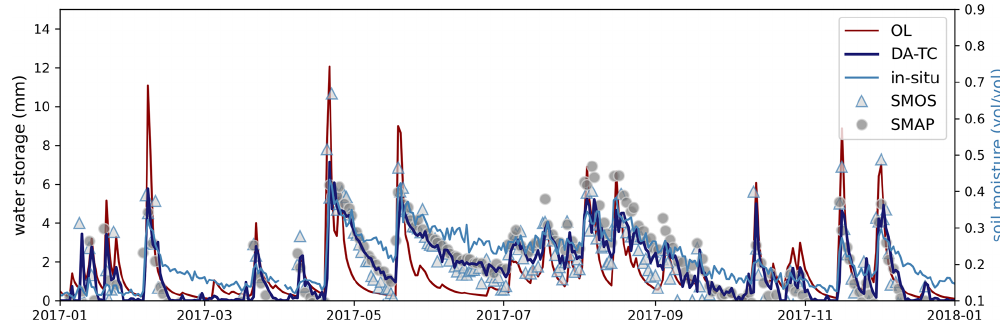
Figure 3. Time series of AWRA-L surface soil water storage estimates from open loop (OL) compared to estimates after data assimila- tion (DA-TC) of SMAP and SMOS soil moisture retrievals at CosmOz monitoring site: Bennets (35.826 ◦ E, 143.004 ◦ S). Note that the in situ soil moisture values are in volumetric